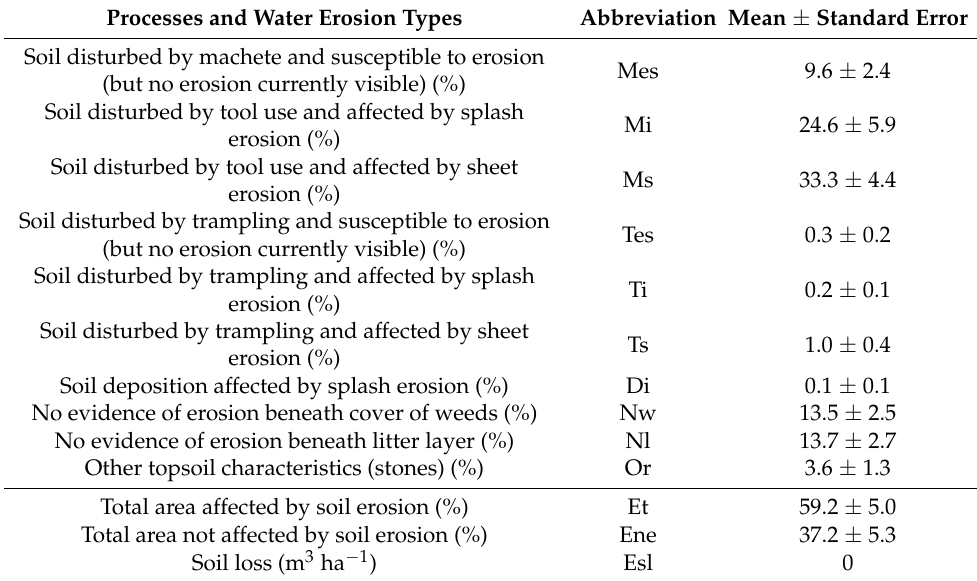
Table 2. Processes and types of soil erosion by water in maize cultivation plots (n = 16).